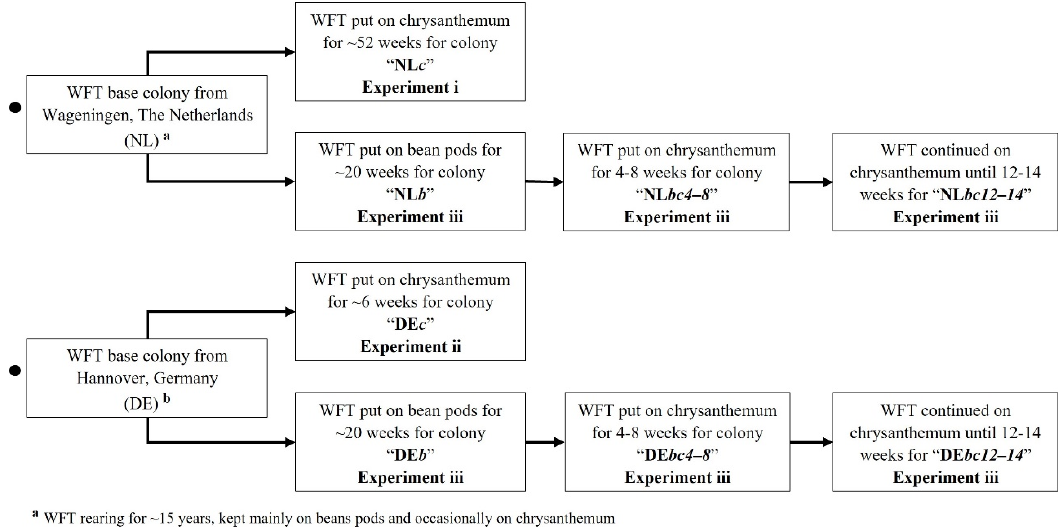
Figure 1. Diagram showing the derivations of WFT colonies from Wageningen, The Netherlands (NL) and Hannover, Germany (DE) from the original base colonies and used in Experiments i–iii. The base German colony (DE) had been reared for approximately 20 years, mostly on whole bean plants ( P. vulgaris L.). After receiving a small sample of this population at